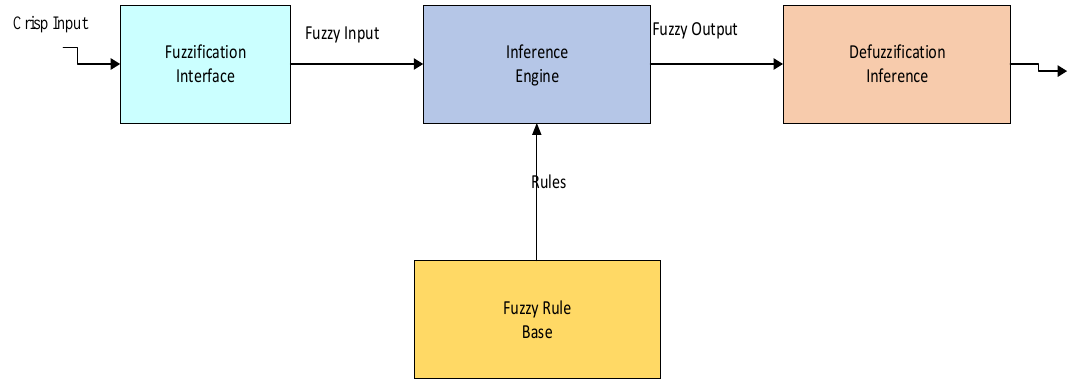
Figure 2. Fuzzy logic system architecture.